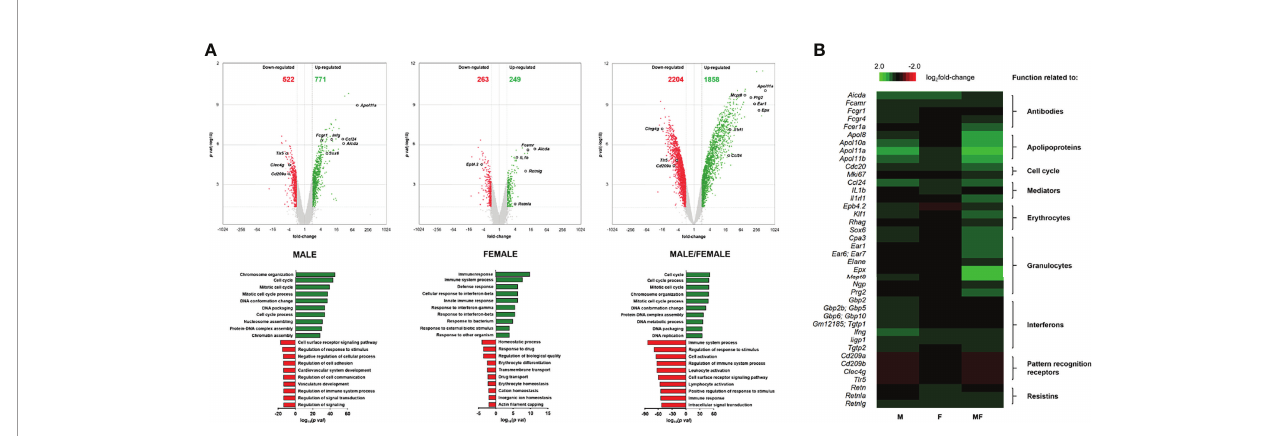
FIGURE 3 | Volcano plot and heatmap of differentially expressed genes in spleen tissue of mice unisexually and bisexually infected with Schistosoma mansoni . (A) Volcano plots (upper panel) visualizing differentially expressed genes of infected (unisexual and bisexual) mice compared to healthy controls (fold change >2 or ≤ 2, LIMMA p value < 0.05 and FDR q value <0.05) plotted against the signi fi cance level (negative log10 p value) and showing signi fi cantly ( p < 0.05) increased (green) and decreased (red) genes in the spleen. Highly regulated genes are encircled in black. Gene ontology analysis (lower panel) displaying enrichments of biological processes of up- and downregulated genes after infection with S. mansoni (8 wk p.i.) compared to naive mice. The ten most enriched categories of biological processes associated with the regulated genes are presented. (B) Heat map of highly regulated genes related to the host immune response in splenic tissue of infected (M, F, MF) compared to control (naive) mice (8 wk p.i., n = 2 – 3). The color scale on the top illustrates the log2 fold change values shown in the heat map. Upregulated genes are highlighted in green whereas downregulated genes are marked red. The baseline data are shown in Supplementary Table 1 .